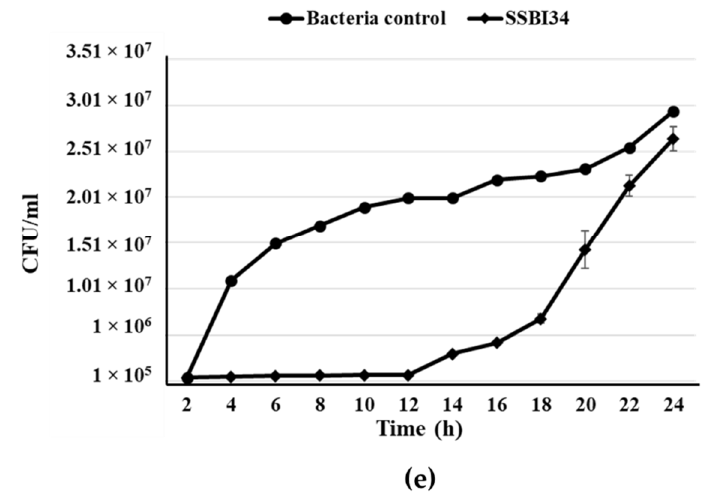
Figure 1. Salmonella -phage-SSBI34 characterization. ( a ) One-step growth curve of SSBI34 when grown on SE-BS17 (MZ503545) at 37 °C in LB medium, with the burst size calculated as per the formula given in the Materials and Methods. Stability of SSBI34 ( b ) when exposed to various temperatures (37 °C–80 °C) and ( c ) when exposed to various pH values (pH 2–pH 9). ( d ) Phage plaques on double-layer agar plates. ( e ) Bacterial growth reduction assay. SSBI34 was able to maintain the bacterial population to background levels for 12–16 h. All values are shown as means ± standard error.